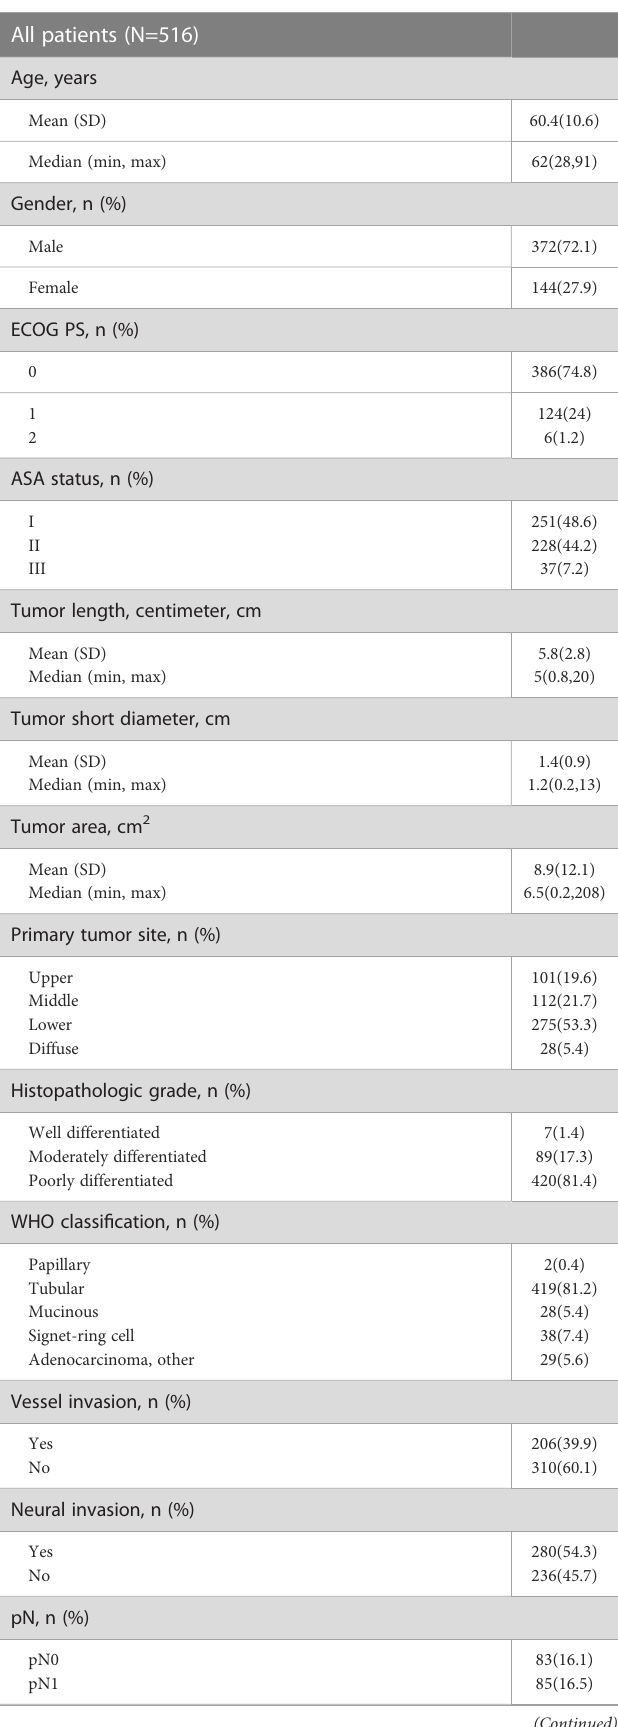
TABLE 1 Clinical participant baseline